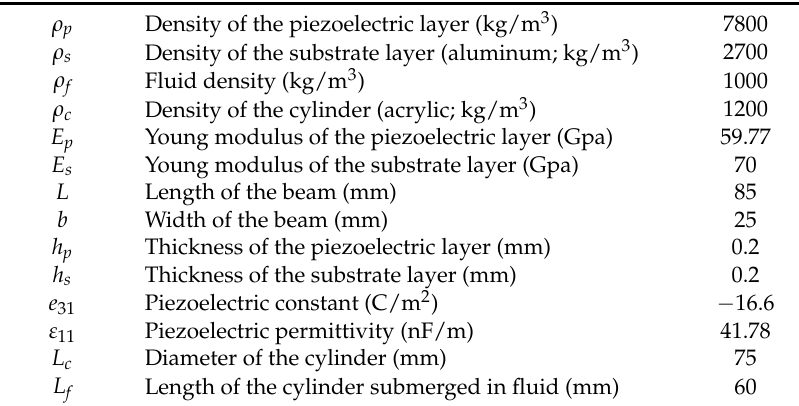
Table 1. The geometric and physical properties of energy harvesting systems.